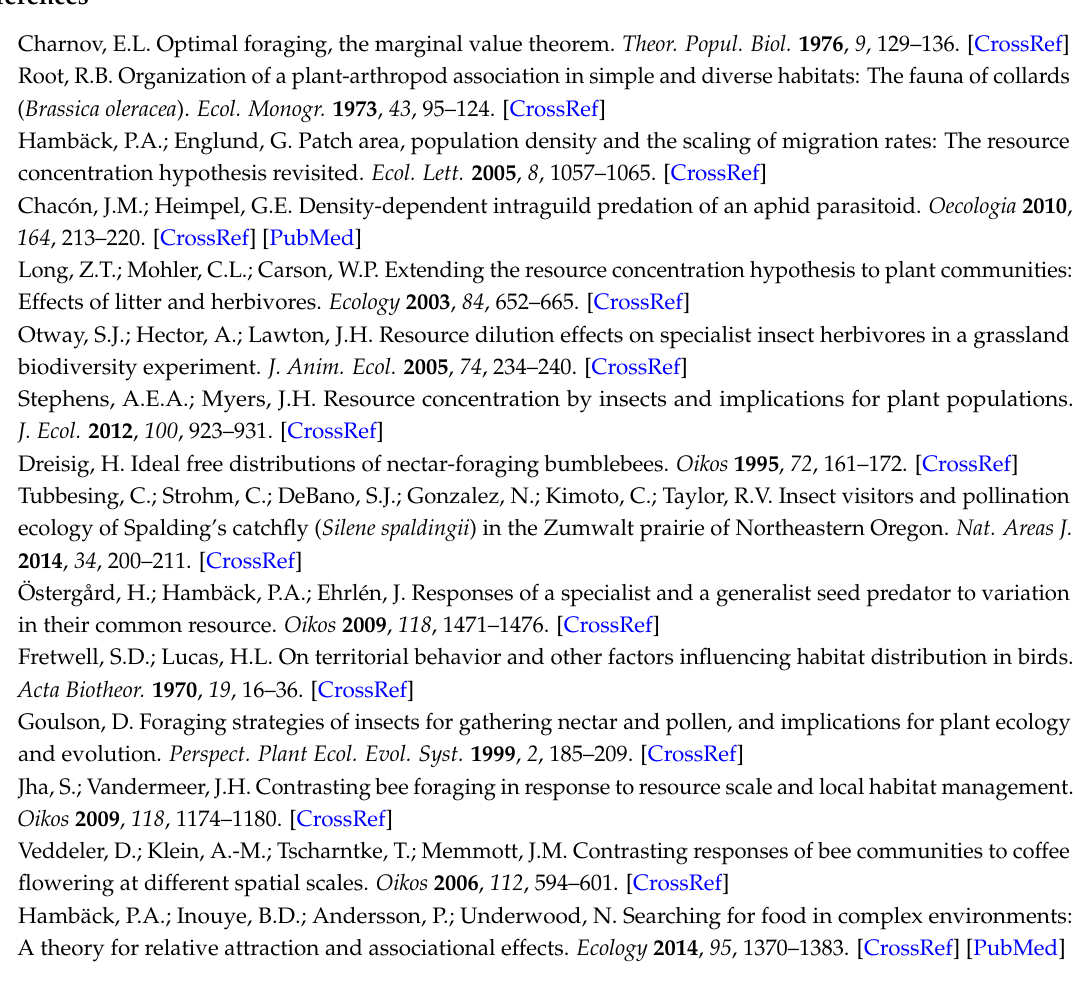
Figure S1: Experimental layout of plants within each site, Table S1: ANOVA tables for floral density and site effects on foraging